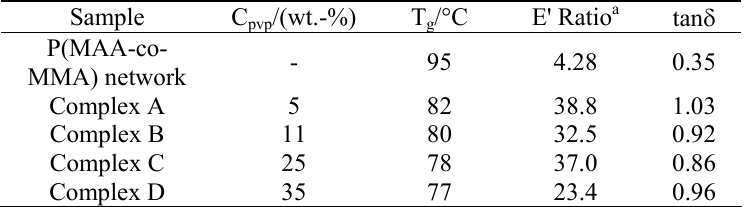
Table 1. Characteristics of P(MAA-co-MMA) network and P(MAA-co-MMA)/PVP complexes formed in the solution of PVP with various concentrations